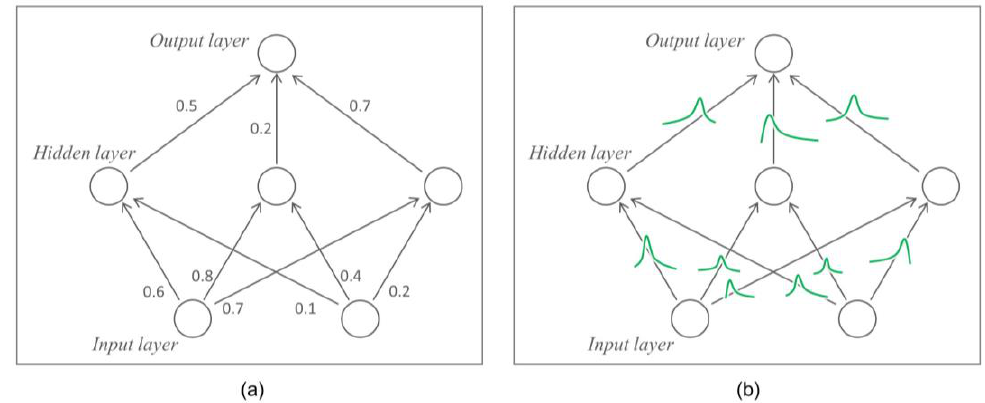
Figure 1. Comparison of deep neural network and Bayesian neural network. ( a ) a deep neural network is a constant with a fixed weight connecting each layer; ( b ) in a Bayesian neural network, the weight connecting each layer is a probability distribution.